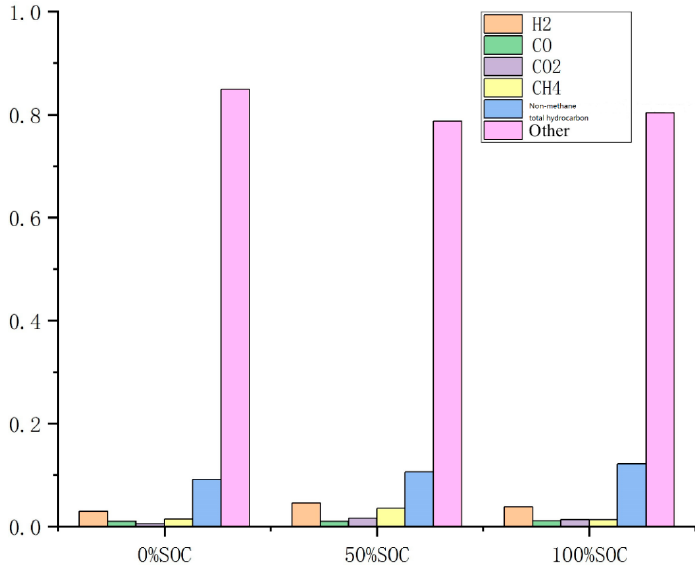
Figure 7. Detected components of the produced gases (%). The principal constituents included CO, H 2 , CO 2 , CH 4 , and C 2 H 4 . Other ingredients included small amounts of water, EMC, and so on [16–